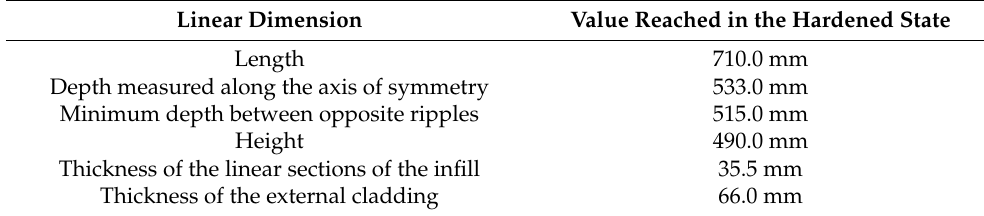
Table 2. Main linear dimensions of the specimen in the hardened state, after shrinkage. Linear Dimension Value Reached in the Hardened State Length 710.0 mm Depth measured along the axis of symmetry 533.0 mm Minimum depth between opposite ripples 515.0 mm Height 490.0 mm 35.5 mm